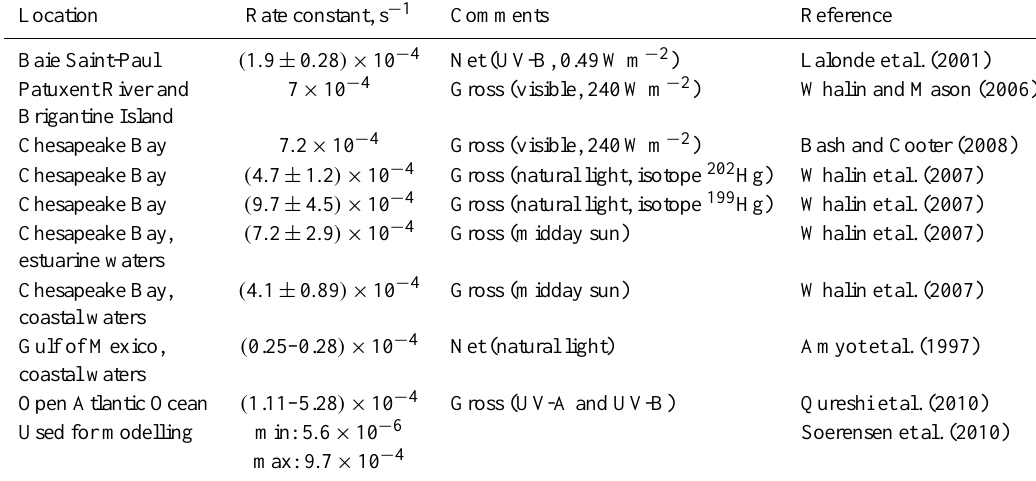
Table 2. Rate constants of mercury photochemical oxidation in seawater. Location Rate constant, s − 1 Comments Reference Baie Saint-Paul ( 1 . 9 ± 0 . 28 ) × 10 − 4 Net (UV-B, 0.49Wm − 2 ) Lalonde et al. (2001) Patuxent River and 7 × 10 − 4 Gross (visible, 240Wm − 2 ) Whalin and Mason (2006) Brigantine Island Chesapeake Bay 7 . 2 × 10 − 4 Gross (visible, 240Wm − 2 ) Bash and Cooter (2008) Chesapeake Bay ( 4 . 7 ± 1 . 2 ) × 10 − 4 Gross (natural light, isotope 202 Hg) Whalin et al. (2007)